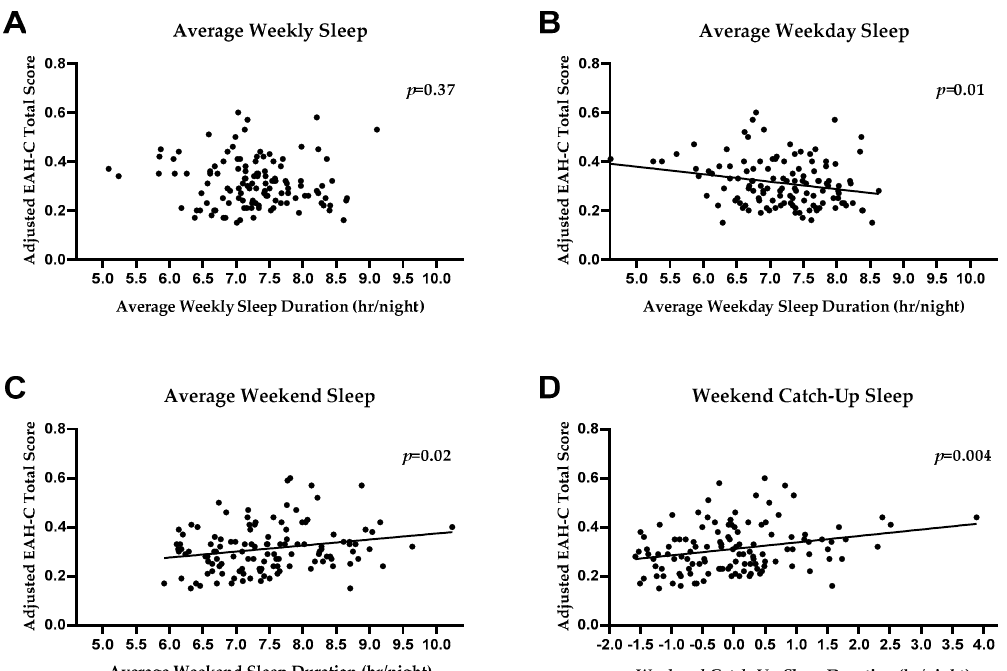
Figure 1. Associations between sleep and eating in the absence of hunger (EAH). There was no association between average weekly sleep and EAH total score ( p = 0.37, A ). There was a significant inverse association between EAH and average weekday sleep ( p = 0.01, B ), and a significant positive association between average weekend sleep and EAH ( p = 0.02, C ). There was a significant positive association between weekend “catch-up” sleep and EAH ( p = 0.004, D ). All analyses were adjusted for age, sex, race, height, total fat mass, and depressive symptoms.